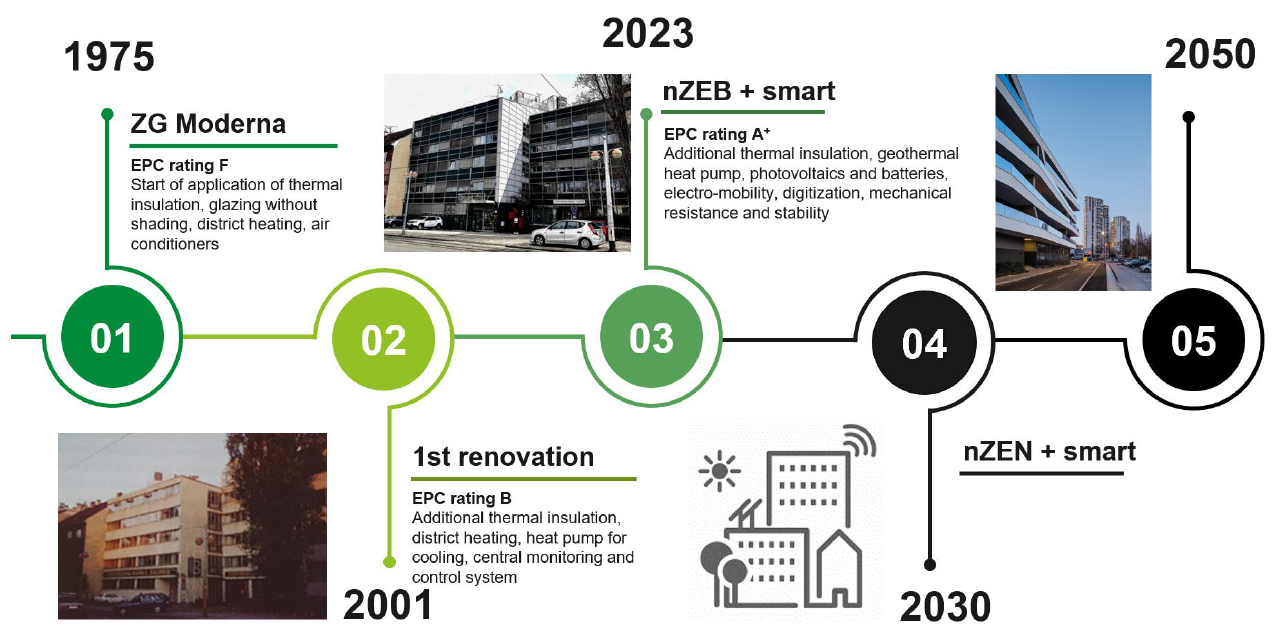
Figure 4. nZEB vision.